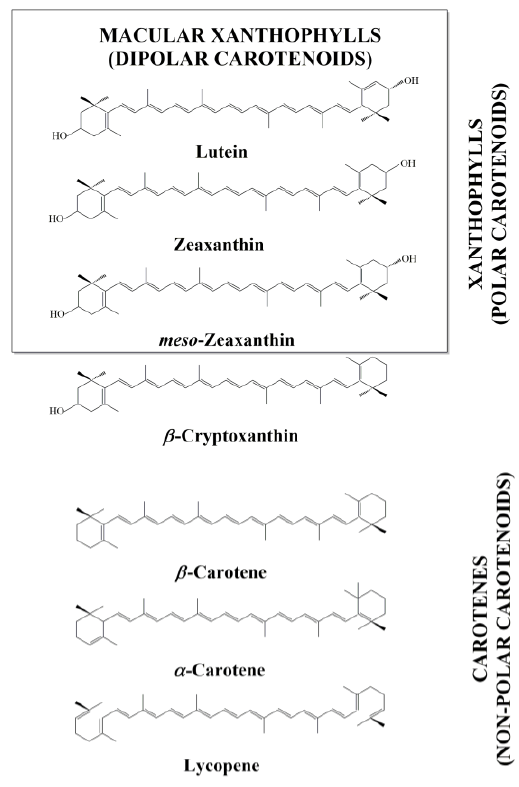
Figure 1. Chemical structures of carotenoids (xanthophylls and carotenes) abundant in food, blood plasma and neural tissue.